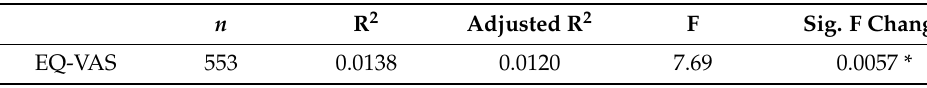
Table 3. ANOVA of EQ-VAS and hospital ownership.